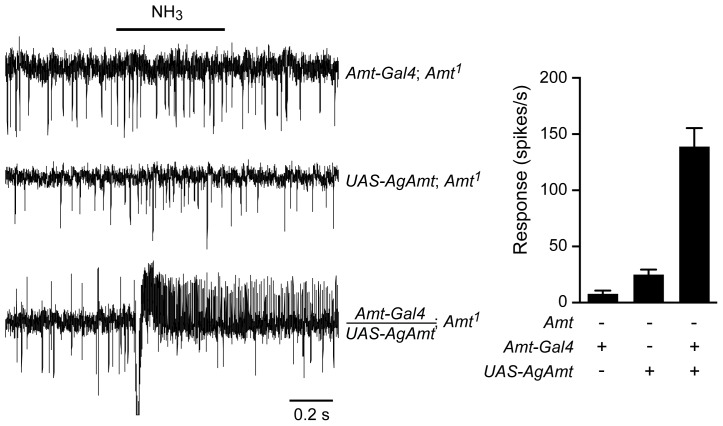

AgAmt from the mosquito Anopheles gambiae can substitute for Drosophila Amt.
Traces on the left show that the lack of response to a 500 ms puff of 0.1% ammonia in Amt1 mutant flies was restored by transgenic expression of AgAmt (n = 8 each, p<0.0001). Mean responses are shown in the graph on the right. Data for Amt-GAL4; Amt1 are from Figure 6C.